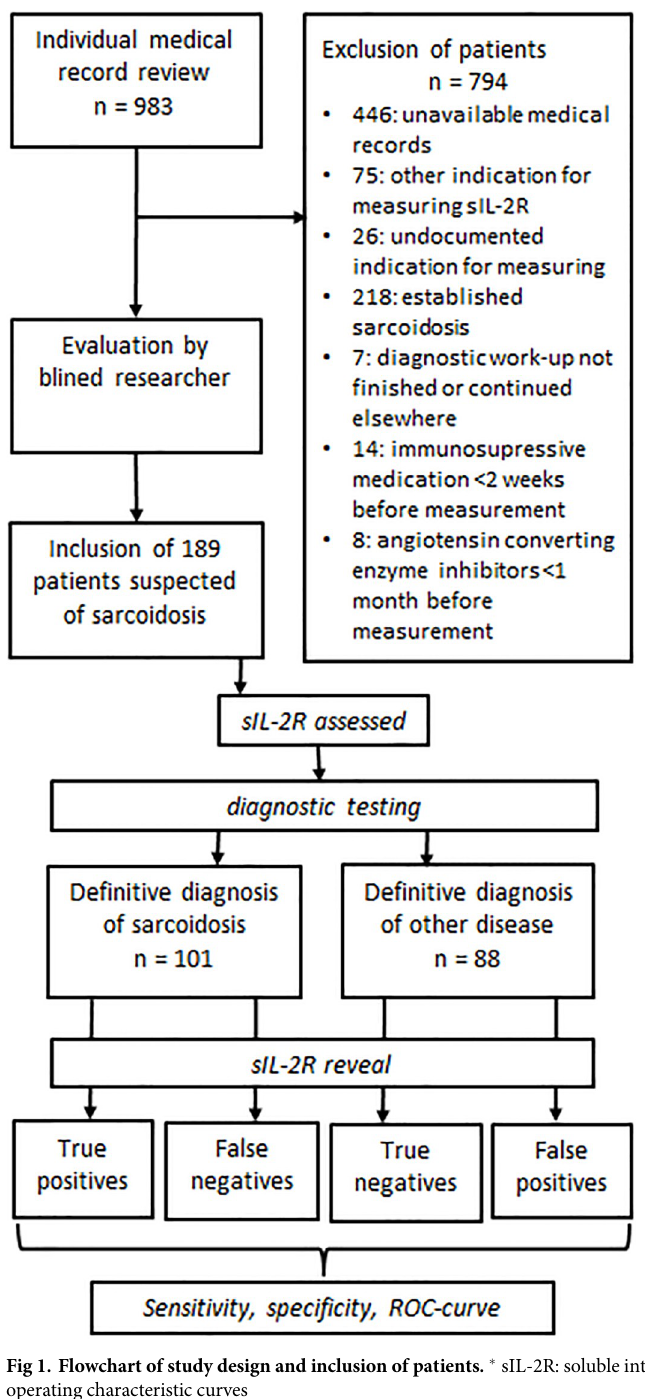
Fig 1. Flowchart of study design and inclusion of patients. � sIL-2R: soluble interleukin 2 receptor. �� ROC: receiver operating characteristic curves